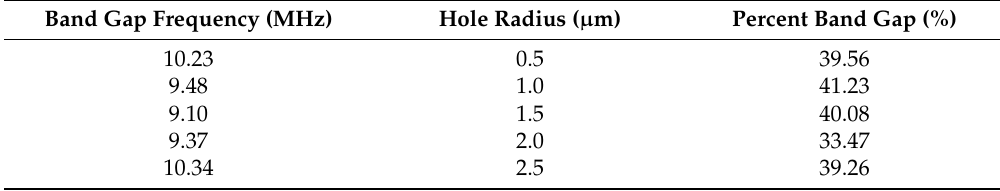
Table 1. Illustration for the effect of Scatterer hole radius on band gap structure of the PnC. Band Gap Frequency (MHz)